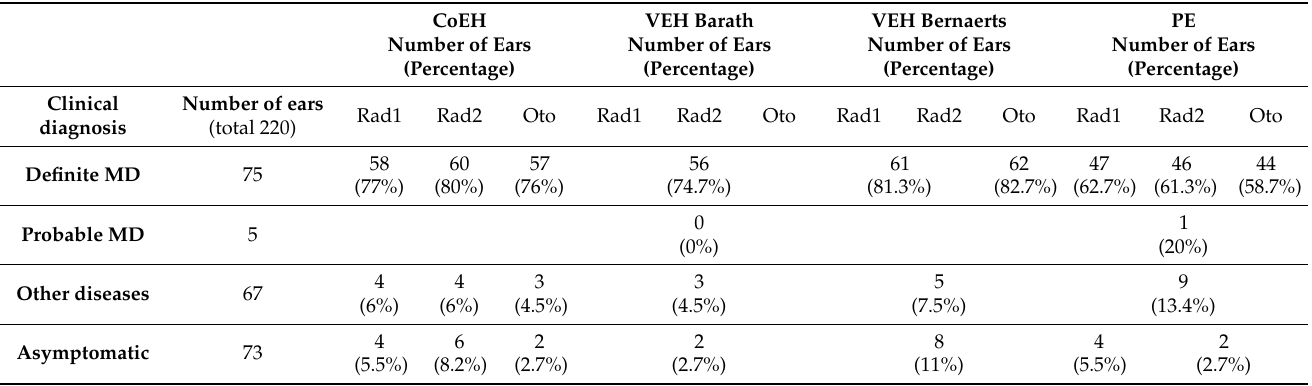
Table 1. The frequency of endolymphatic hydrops and increased perilymphatic enhancement of the inner ear structures in analyzed ears evaluated by three observers (two radiologists and an otorhinolaryngologist in